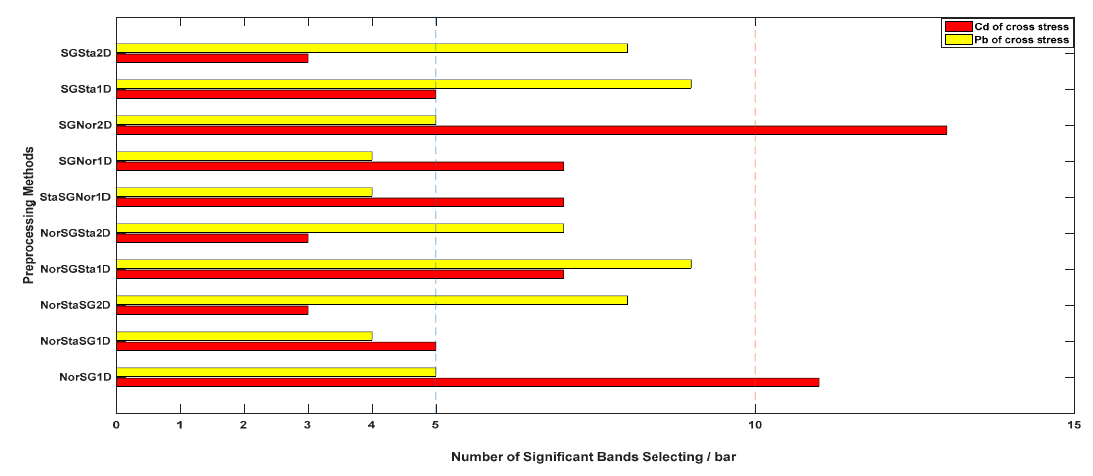
Figure 3. Numbers of significant bands selected with di ff erent pre-processing